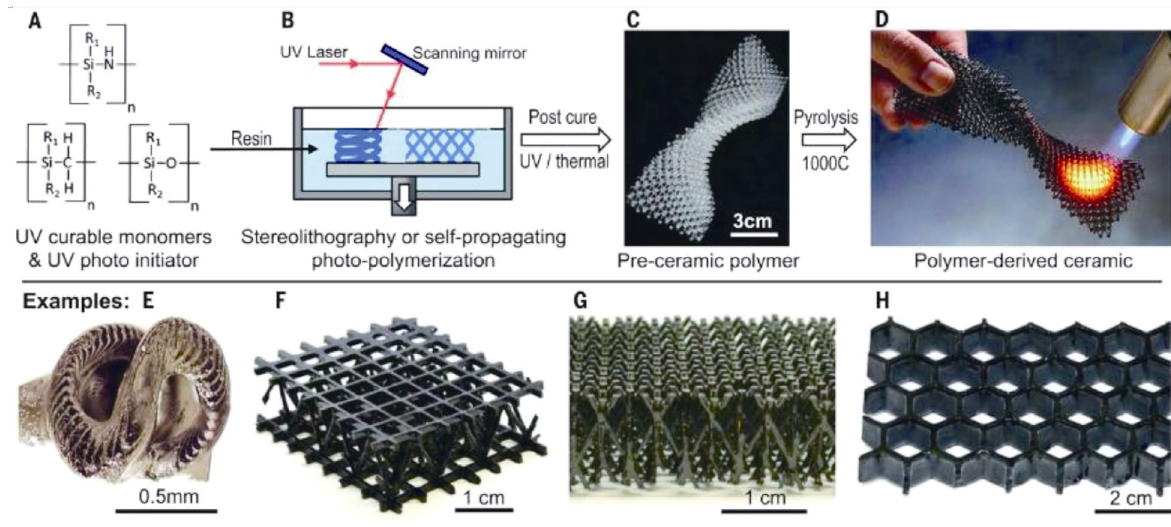
Fig. 6 (A) Mixing of UV-curable preceramic monomers with a photoinitiator. (B) 3D printing process of the mixed polymer. (C) Printed micro-lattice. (D) Pyrolysis into ceramic material. (E–H) Several cellular examples. Reproduced with permission from Ref. [91], © American Association for the Advancement of Science 2016.